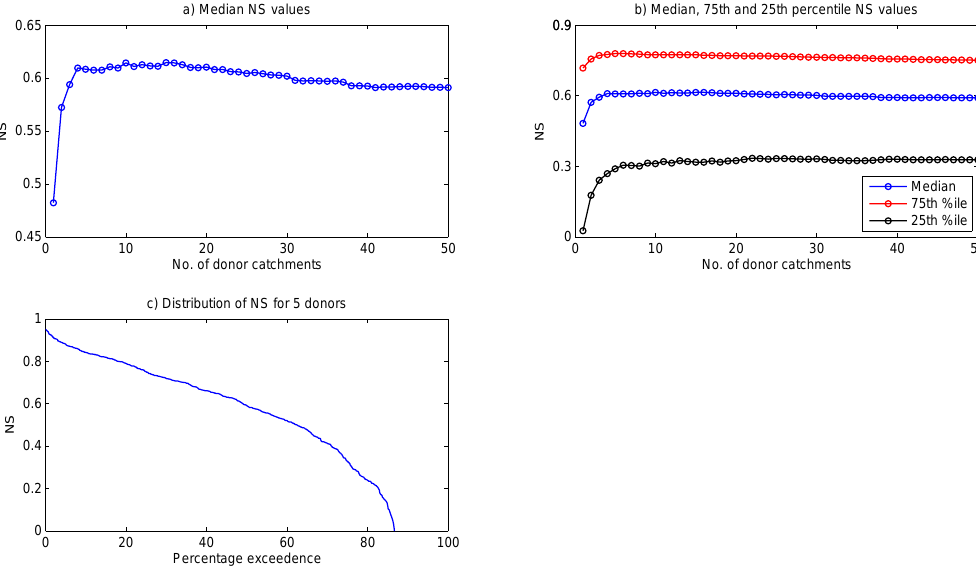
Fig. 2. (a) Relationship between number of donor catchments and median NS values, (b) relationship between number of donor catchments and median, 75th percentile, and 25th percentile NS values, and (c) distribution of NS values of simulated streamflows for the configuration of five donor